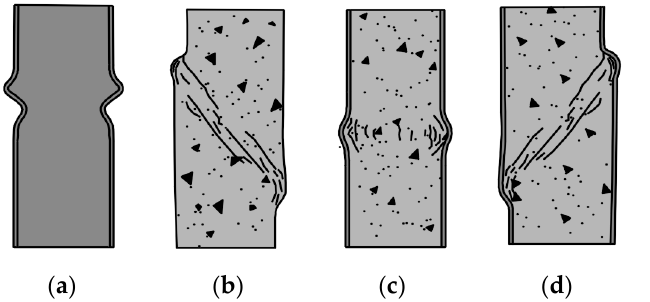
Figure 5. Local failure modes of axially compressed stub columns: ( a ) steel—local buckling, ( b ) con- crete without reinforcement—shear ( c ) CFST—elephant foot, ( d ) CFST—shear and sliding, based on [36,41].